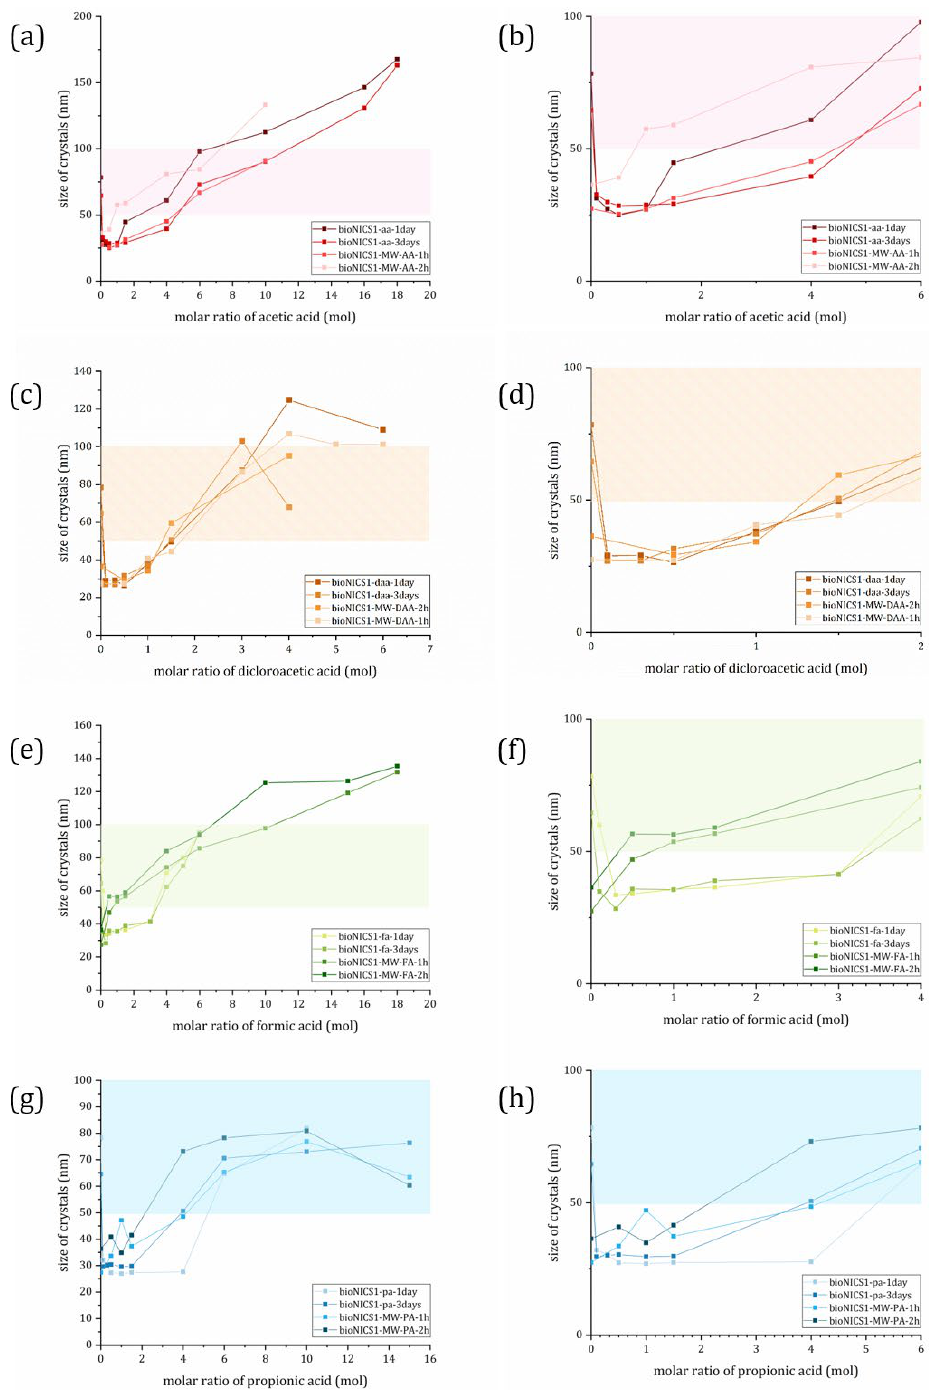
Figure 3. Calculated size of crystal domains plotted against molar addition of used additive; ( a ) and ( b ) acetic acid; ( c ) and ( d ) dichloroacetic acid; ( e ) and ( f ) formic acid; and ( g ) and ( h ) propionic acid. Colored ribbon represents a region of 50–100 nm sizes. Graphs on the right side of figure show lower molar additions of acids to emphasize seesaw trend. Error bars are omitted for clarity. Graphs with error bars are found in Supplementary Figure S10.